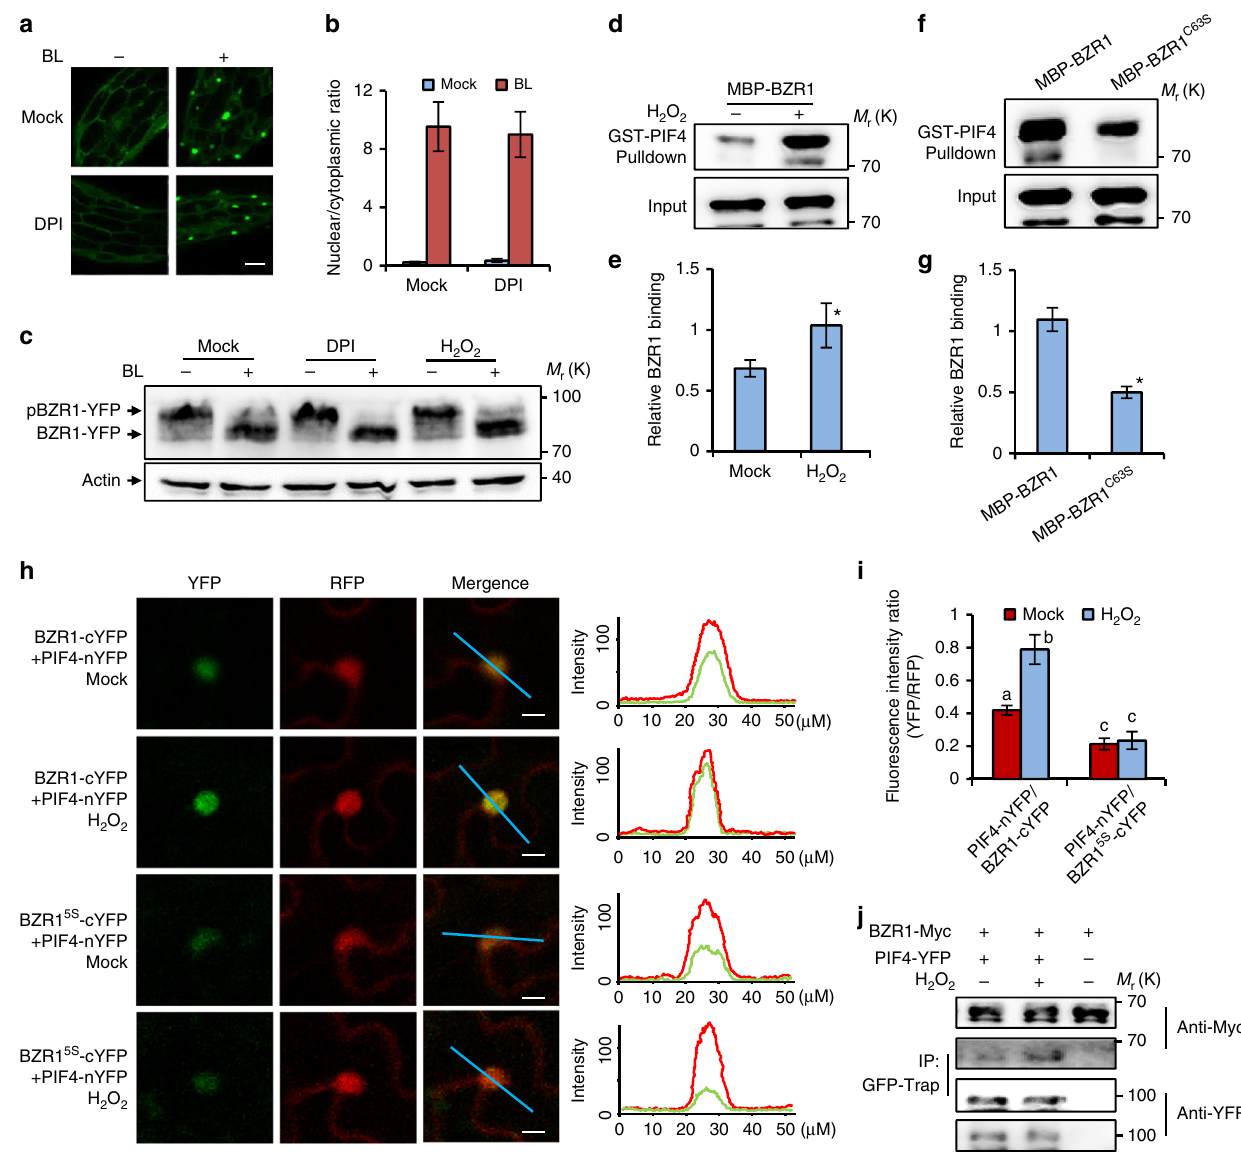
Fig. 5 H 2 O 2 enhances the interaction between BZR1 and PIF4 in vitro and in vivo. a DPI treatment had no signi fi cant effects on BL-induced nuclear localization of BZR1-YFP. Transgenic Arabidopsis plants expressing BZR1-YFP were grown on ½ MS medium containing 2 µ M PPZ or 2 µ M PPZ plus 1 µ M DPI in the dark for 5 days, and then treated with 100 nM BL or mock solution for 3 h. Scale bar, 20 μ m. b Quanti fi cation of fl uorescent intensities ratio between nuclear and cytoplasmic signals in a . The standard errors calculated from 50 cells for each treatment. c Immunoblot analysis of phosphorylated and dephosphorylated BZR1 in 5-day-old dark-grown pBZR1:BZR1-YFP using anti-YFP antibody. Actin bands showed protein loadings. d – g In vitro pull-down assays showed that H 2 O 2 enhanced, but Cys-63 mutation to Ser reduced, the BZR1 binding to PIF4. e , g show the quanti fi cation of pull-down assays (normalized to input) in the d and f , respectively. Error bars represented the s.d. of three independent experiments. * p < 0.05, as determined by a Student ’ s t -test. h , i rBiFC confocal images showed that H 2 O 2 enhanced, but mutation of cysteines reduced the interaction between BZR1 and PIF4 in plants. The fl uorescent signals of YFP (BiFC) and RFP (reference) were determined along a line drawn on the confocol images using ImageJ software. Error bars, s.d. ( n = 50 images). Different letters above the bars indicated statistically signi fi cant differences between the samples (two-way ANOVA, p < 0.05). Scale bar, 10 μ m. j Co-immunoprecipitation (CoIP) assays showed that H 2 O 2 increased the interaction between BZR1 and PIF4 in plants. The Arabidopsis mesophyll protoplast transformed with BZR1-Myc and/or PIF4-YFP were treated with mock solution or 100 μ M H 2 O 2 for 1 h, then immunoprecipitation was performed using GFP-Trap agarose beads, and the immunoblots were probed using anti-Myc and anti-YFP